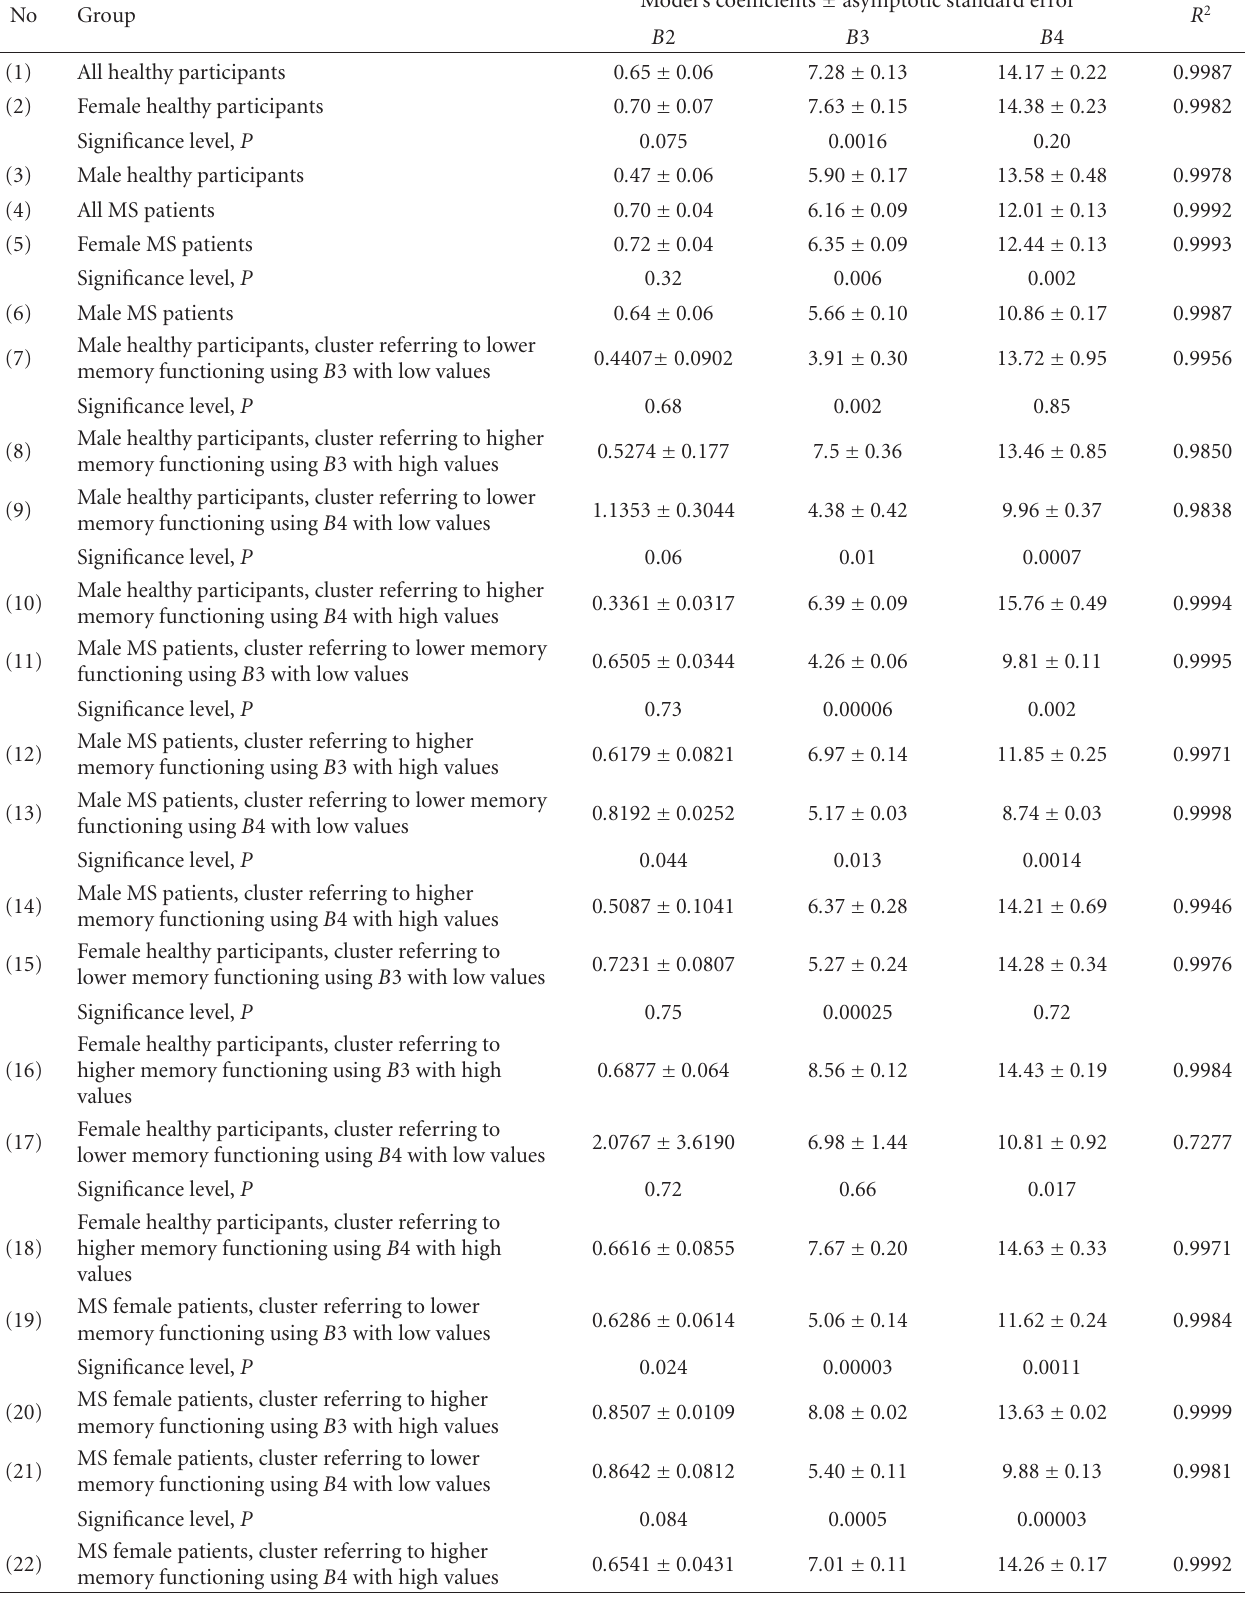
Table 2: Values of the Model’s coe ffi cients for the averaged learning